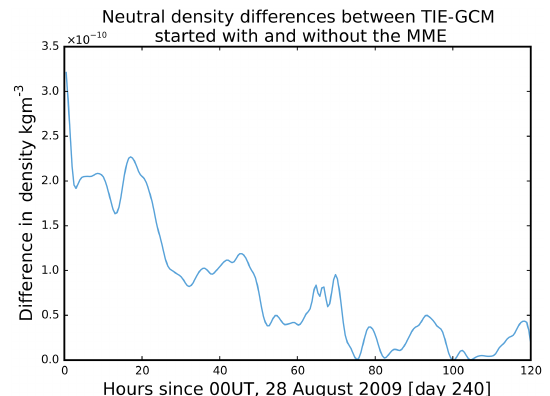
Figure 14. Differences between the standard TIE-GCM model run and TIE-GCM ran using the MME as its initial conditions (at time 0). It can be seen that it takes over 70h for the models to start to converge again.